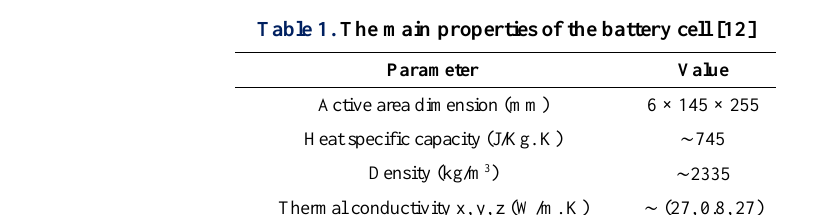
Thermal conductivity x, y, z (W/m.